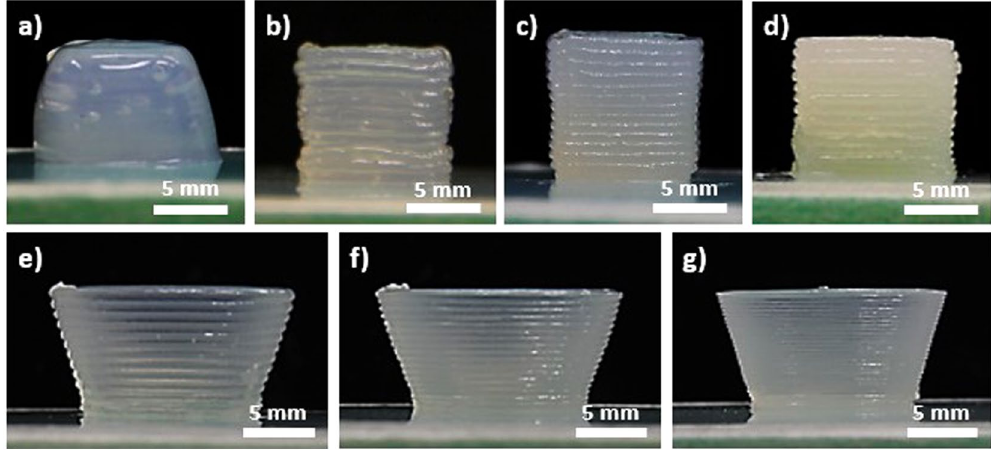
Figure 1. From 500 µ m nozzle tip size, 1 cm 3 cubic CNC gel structures at ( a ) 11.8, ( b ) 15, ( c ) 20, and ( d ) 30 wt% are illustrated. Using 20 wt% CNC gel, bowl structures from nozzle tip size of ( e) 500, ( f ) 400, and ( g ) 200 µ m are also